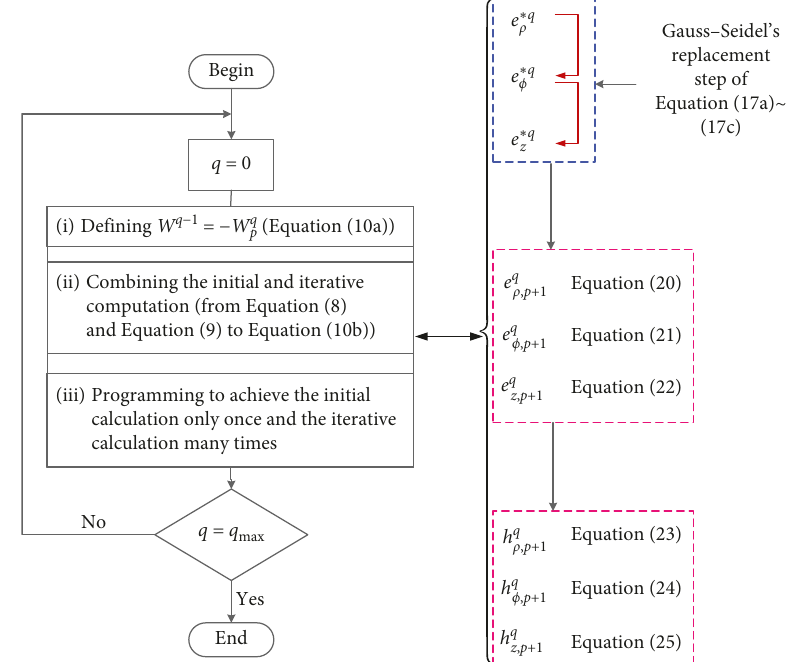
Figure 1: Overall execution process of the proposed algorithm.